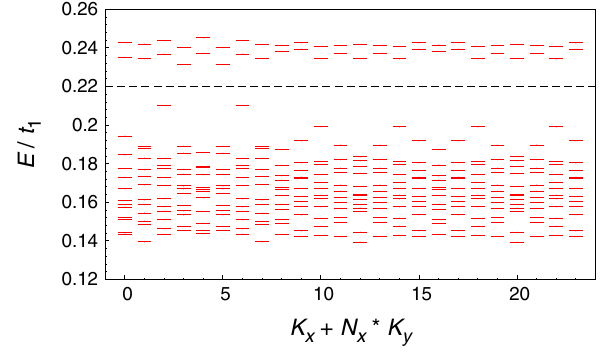
FIG. 7. Low-energy spectrum for N ¼ 7 , N x ¼ 8 , N y ¼ 3 . The number of states below the dashed line is 12 in all sectors and matches the number of expected quasihole states given by the generalized Pauli principle.